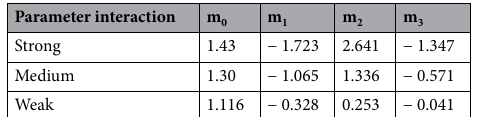
Table 2. Fluid density data for different fluid-wall interactions 21